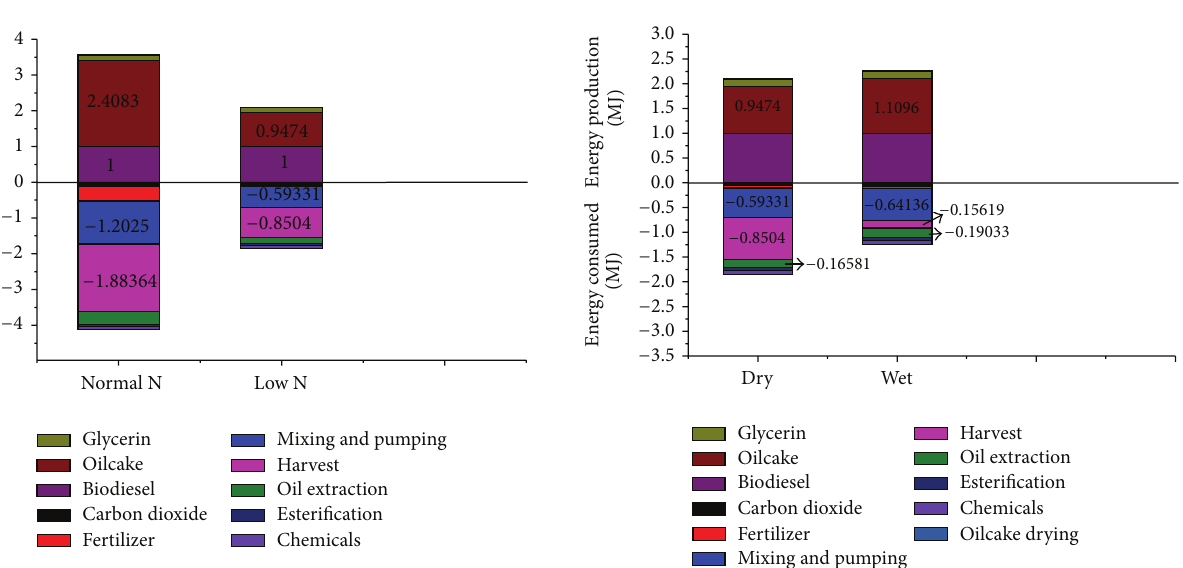
Figure 6: Energy input and output of biodiesel production using oil extracted from dried and wet algae.